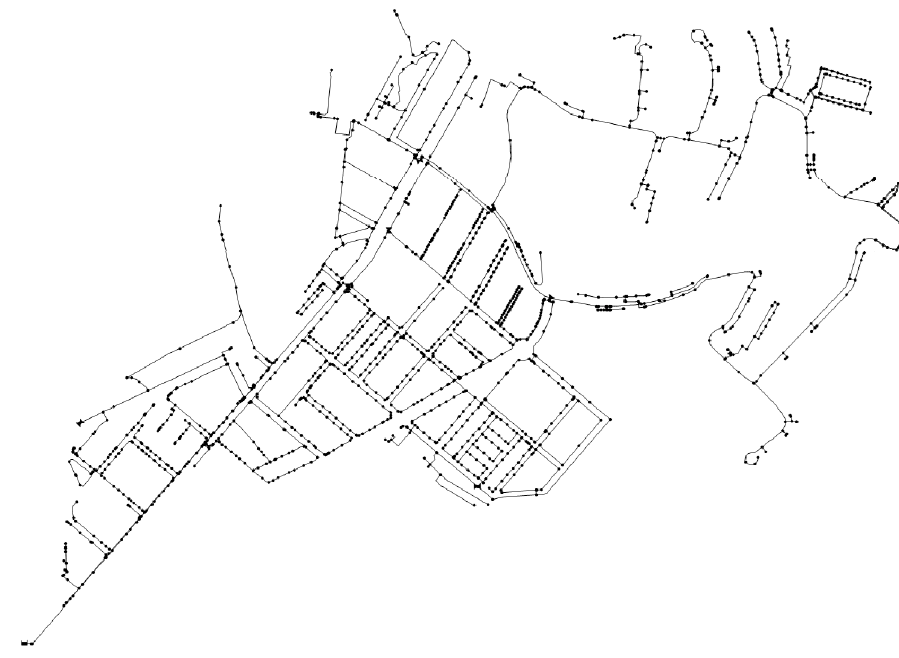
Figure 4. Network skeleton (dynamic analysis, case 2).